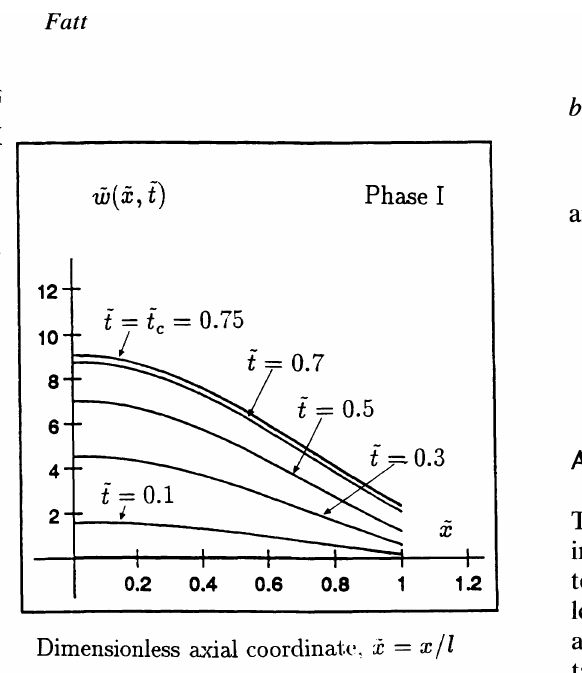
FIGURE 6 Normalized transient deflection profiles within the central bay.